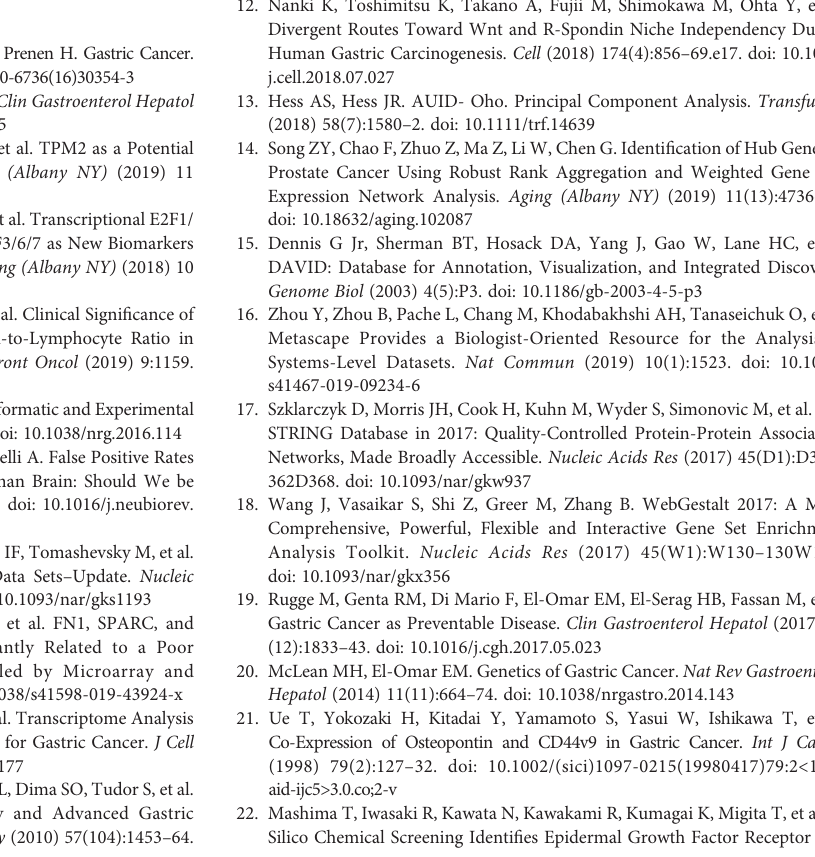
Supplementary Figure 1 | (A) Relative expression of MMP7 in mouse model of carcinoma in situ by RT-qPCR analysis. P<0.001, compared with control. (B) Relative expression of CDH3 in mouse model of carcinoma in situ by RT-qPCR analysis. P<0.001, compared with control. (C) Relative expression of LEF1 in mouse model of carcinoma in situ by RT-qPCR analysis. P<0.001, compared with